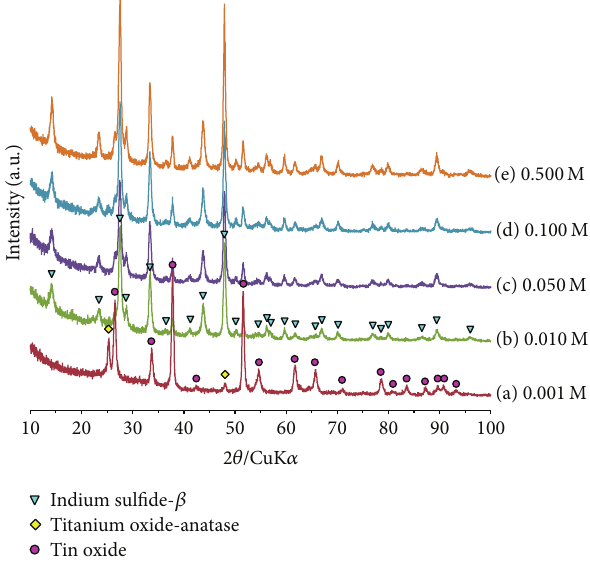
Figure 1: The XRD patterns of the prepared TiO 2 seed blocking/In 2 S 3 photosensitizer (0.001, 0.01, 0.05, 0.1, and 0.5 M) layered